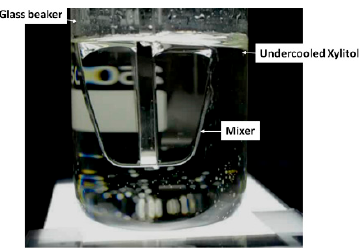
Figure 1. Picture of the mixer within a sample of undercooled Xylitol in a glass beaker at a starting temperature T0 = 50 °C ( Δ T = 45 °C) before mechanical agitation.